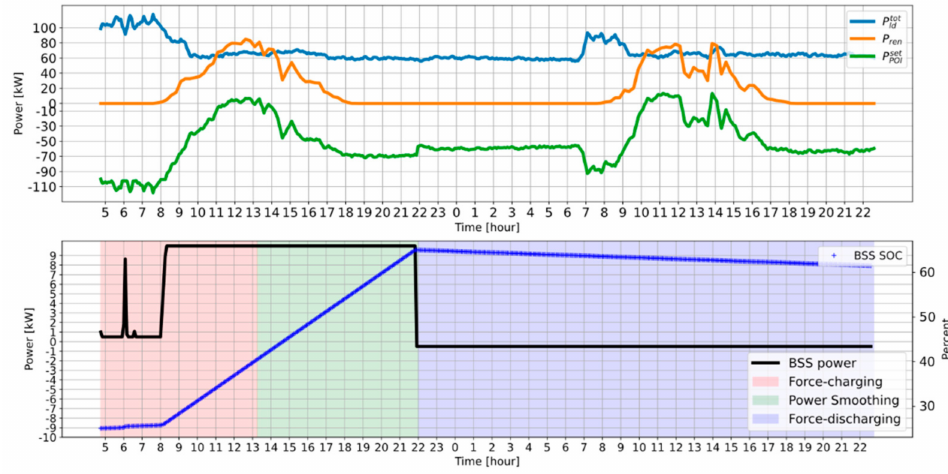
Figure 17. Test results for Case-c: MG in SS1 is tested for two